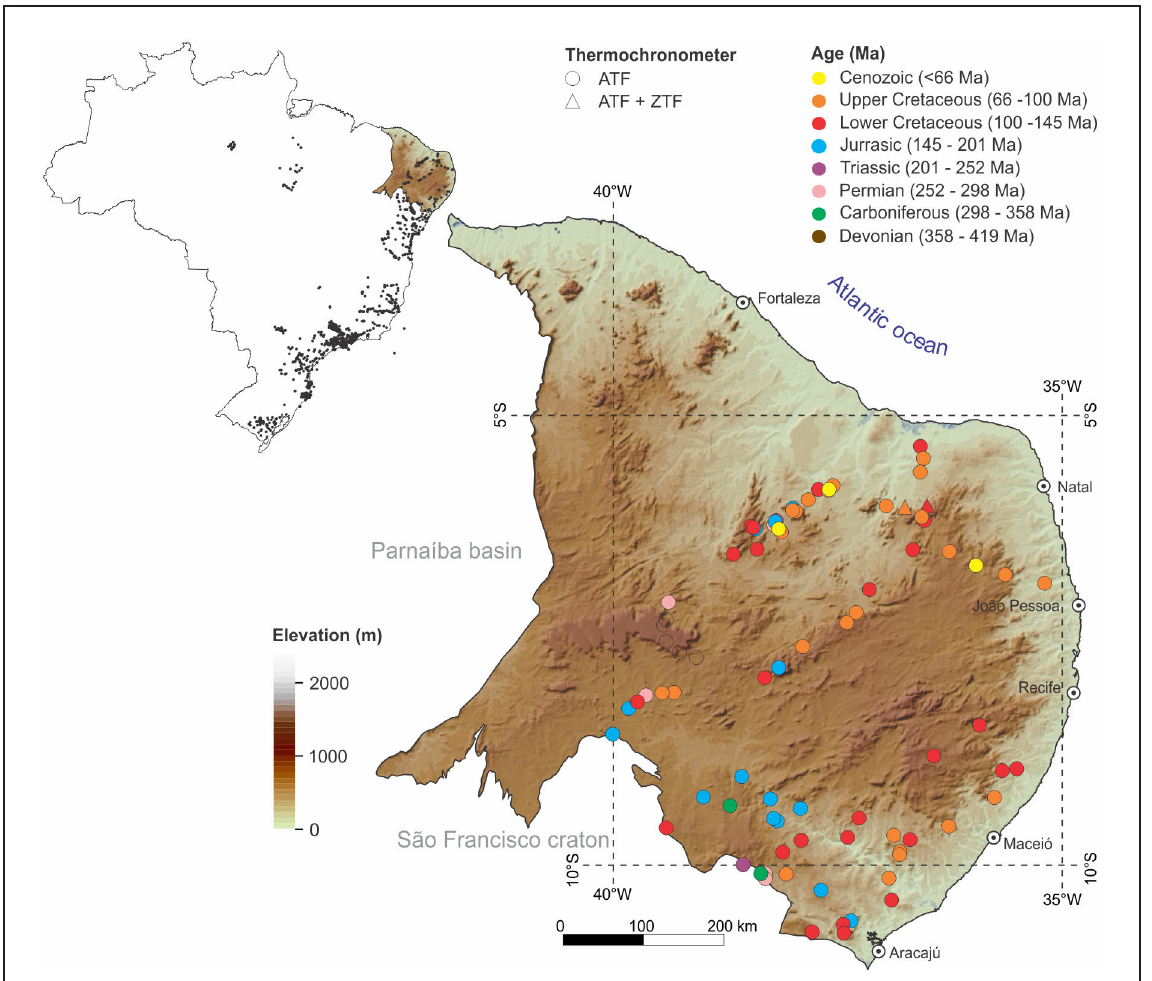
FIGURE 7 . Thermochronological data set published in the Borborema